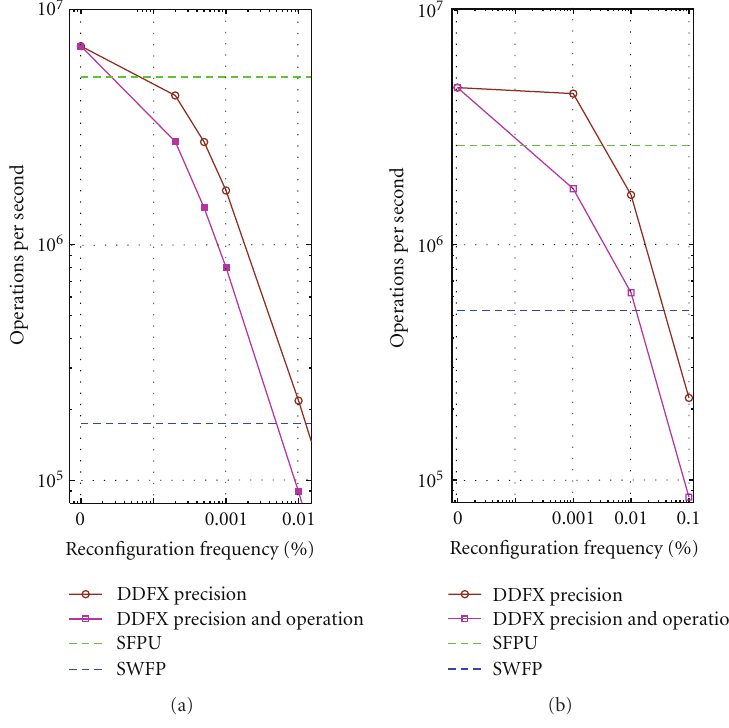
Figure 10: Performance results for 4 DDFX cores versus reconfiguration frequency for Virtex II Pro MicroBlaze (a)and Virtex 4 PowerPC405 (b). Here, 0% cannot be represented in our logarithmic scale, thus it was included as the leftmost point in the graph. These measurements were taken using running hardware systems described in Section